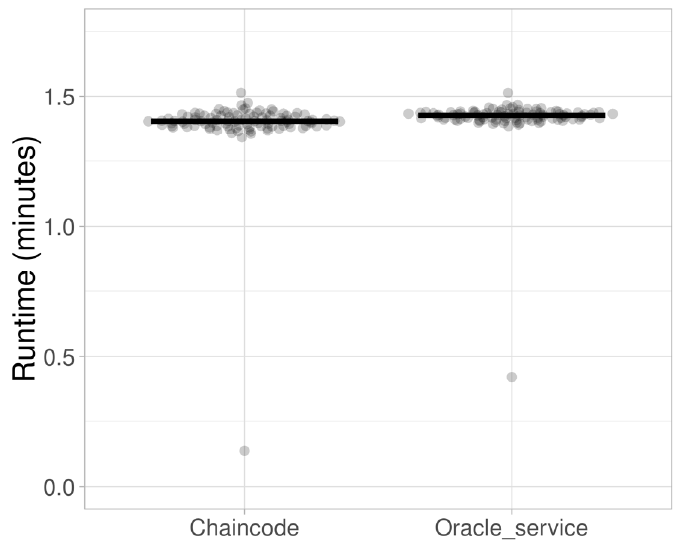
Figure 13. Distribution of runtime results using a network of 13 peers with the dataset of 32,768 records in the model testing experiment. The median runtime for model validation was 1 min 24 s for the chaincode ( left ) and 1 min 26 s for the oracle service ( right ).